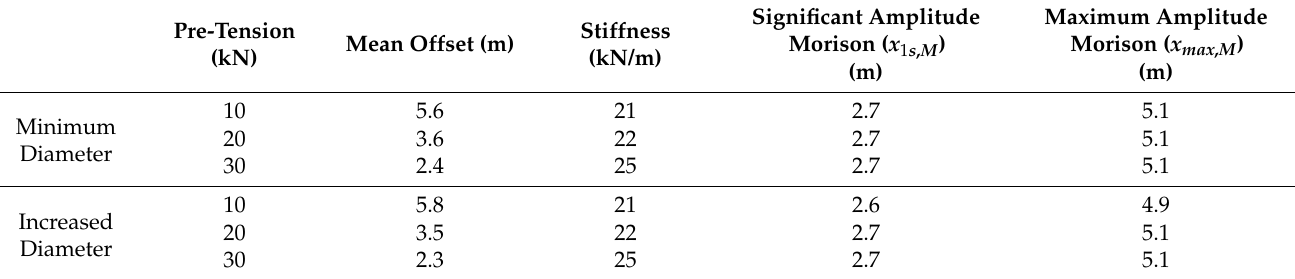
Table 11. Case 2, wave results Morison.